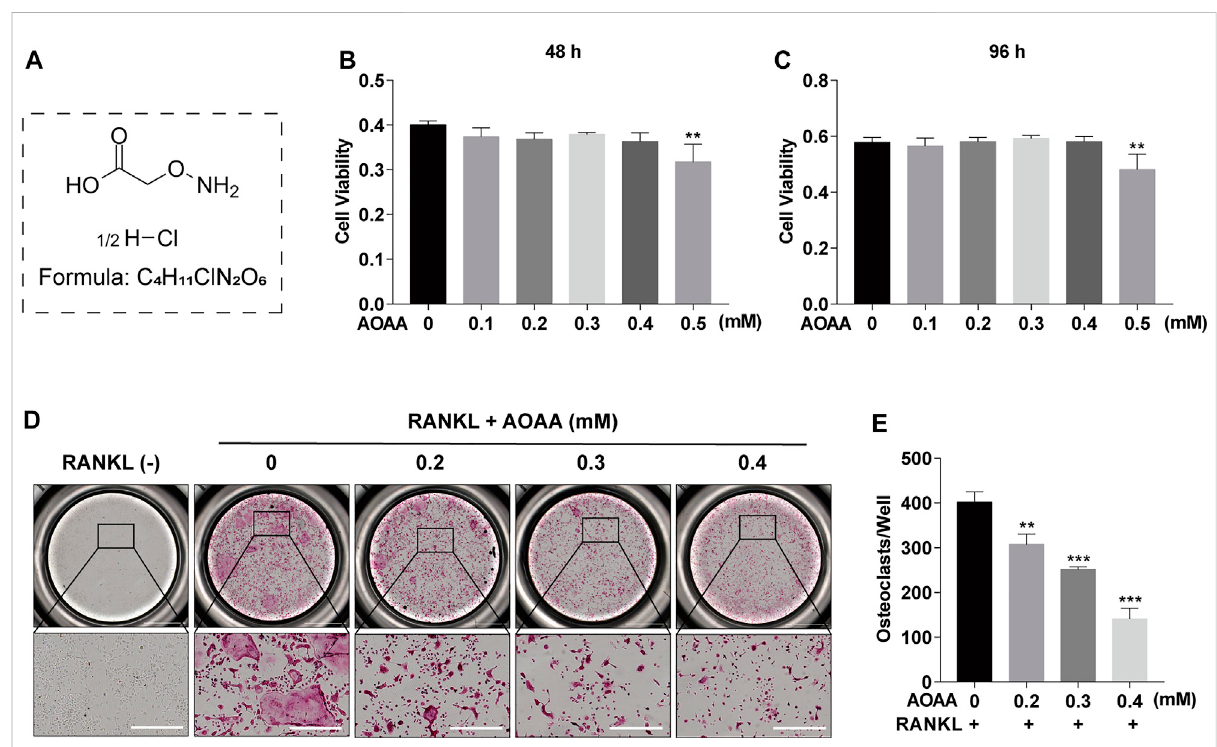
FIGURE 1 AOAA suppresses RANKL-induced osteoclastogenesis in vitro (A) The chemical structure of AOAA. (B,C) CCK-8 assay was used to detect the cell viability of BMMs after treatmentwith AOAA for 48 and 96 h. (D) Representative images of TRAP staining (scale bar = 500 µM). (E) Quanti fi cation ofTRAP + osteoclastsineachwell(nuclei ≥ 3).Allexperimentaldataareexpressedasmean±SD( n =3). **p < 0.01, ***p < 0.001comparedwiththatin the control group (AOAA, 0 mM). One-way ANOVA was